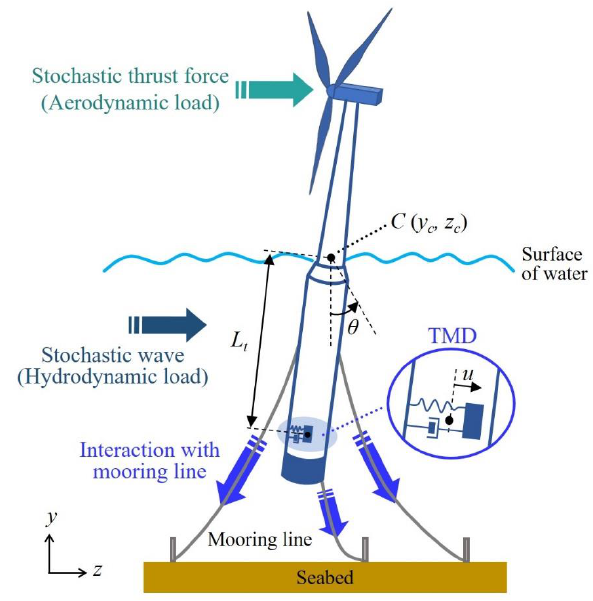
Figure 1. Schematic of the floating offshore wind turbine model.